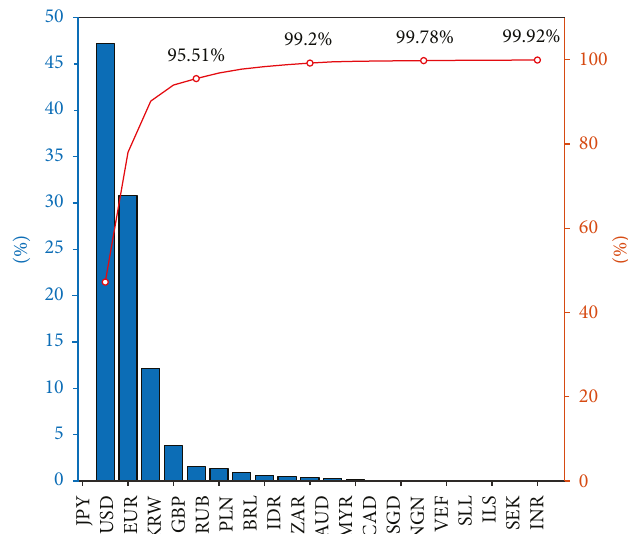
Figure 1: Share of each exchange rate and accumulative